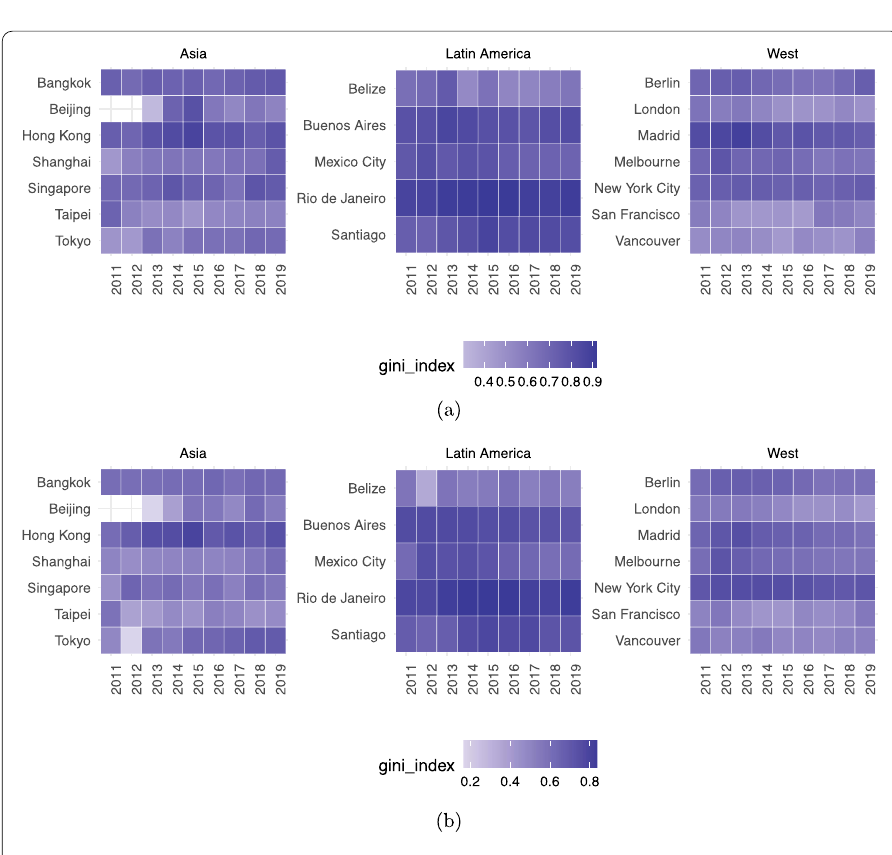
Figure 5 Geographic inequality measured as Gini coefficient of the number of reviews (plot a) and number of listings (plot b) per city and per